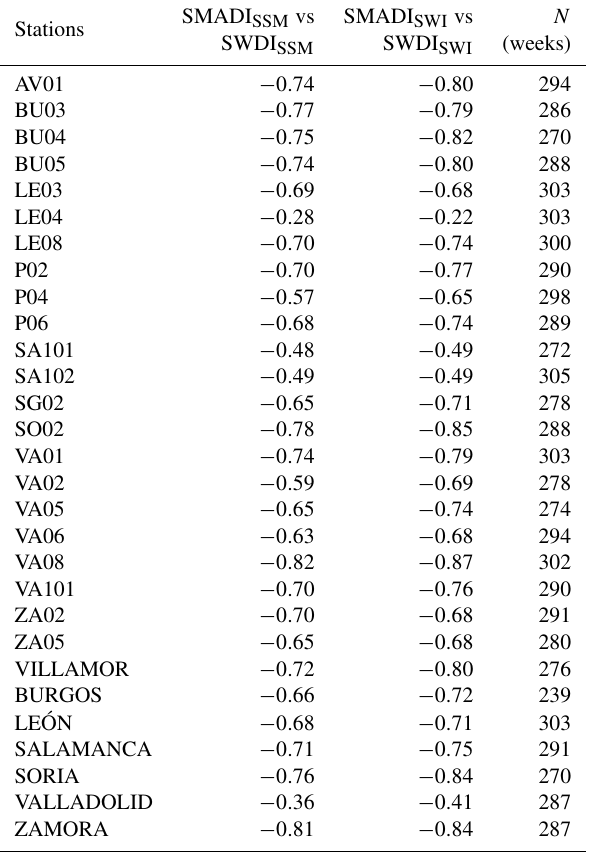
Table 1. Correlation ( R ) between SMADI SSM and SWDI SSM , and between SMADI SWI and SWDI SWI . All values were significant ( p - value<0.05). The number of weeks with available data ( N ) is also